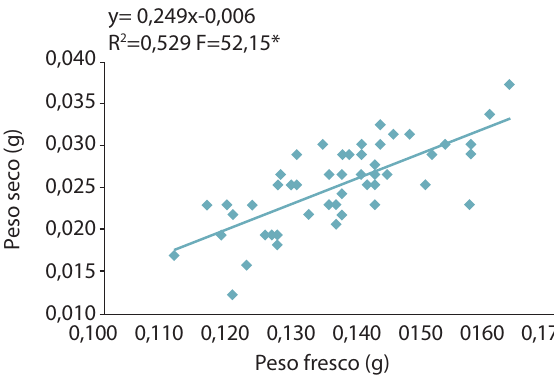
Peso fresco Figura 2. Curva de regressão obtida para as alíquotas de pesos fresco e seco de discos de discos de folhas de